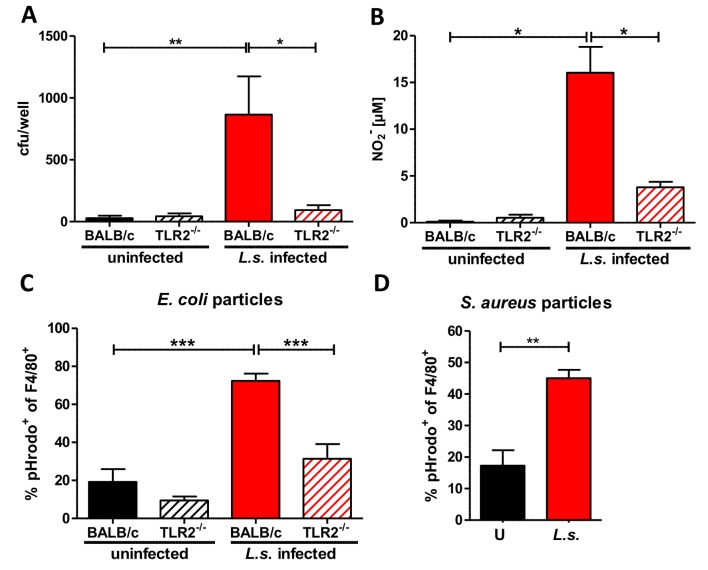
Anti-bacterial effector mechanisms are enhanced by L. sigmodontis infection in a TLR2 dependent manner.(A) Colony forming units (cfu) obtained by a gentamycin assay using peritoneal macrophages derived from chronic L. sigmodontis (L.s.)-infected wild type and TLR2-/- mice and respective uninfected controls three hours after i.p. E. coli injection. (B) Nitrite concentrations of the same macrophages as in (A) after ex vivo cultivation for 48 hours. Frequency of peritoneal F4/80-positive macrophages from L.s.-infected and uninfected wild type and TLR2-/- mice (n = 5 per group) that phagocytosed pHrodo E. coli-BioParticles 90 minutes post injection (C) or from L.s.-infected and uninfected wild type mice (n = 5 per group) that phagocytosed pHrodo S. aureus-BioParticles three hours post injection (D). (A) Pooled data from two independent experiments with at least four mice per group. Data shown in (A-C) is illustrated as mean + SEM and was tested for statistical significance by 1-way ANOVA followed by Dunn’s multiple comparisons test; Data in (D) is also shown as mean + SEM and was tested for statistical significance by Mann-Whitney U test. *p< 0.05; **p< 0.01; ***p<0.001.